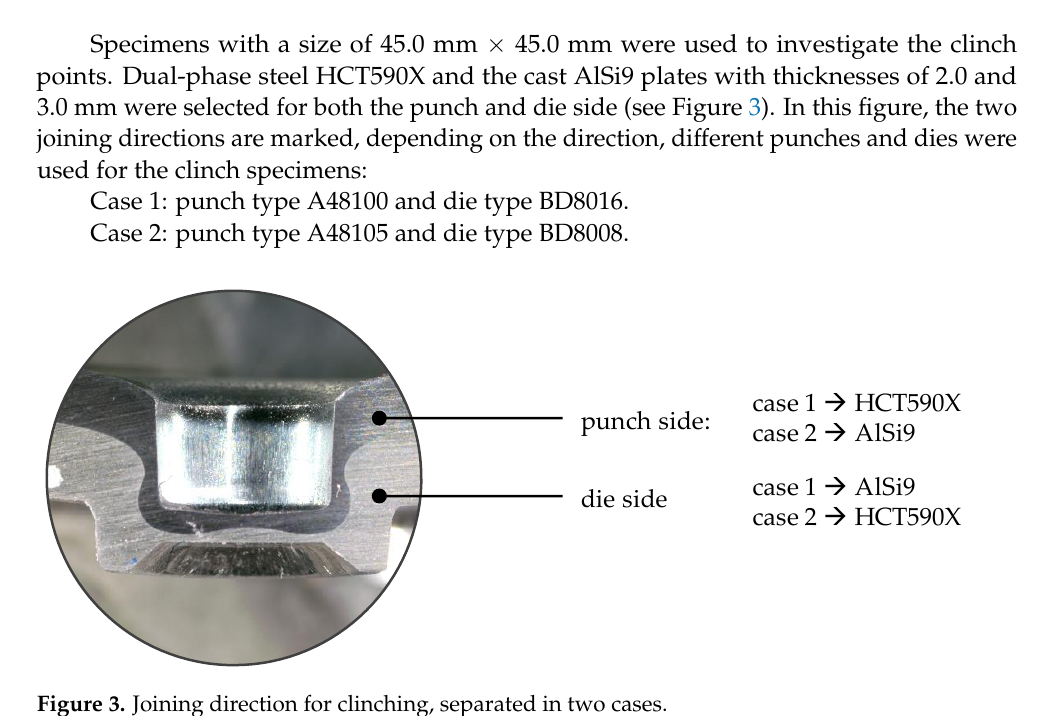
Figure 3. Joining direction for clinching, separated in two cases.